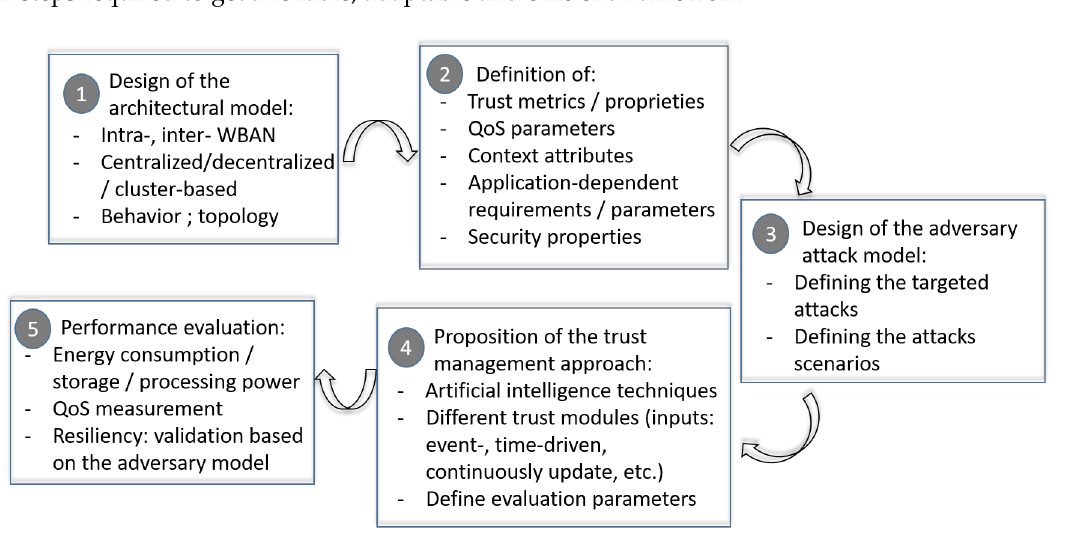
Figure 7. How to design and implement a WBAN trust management